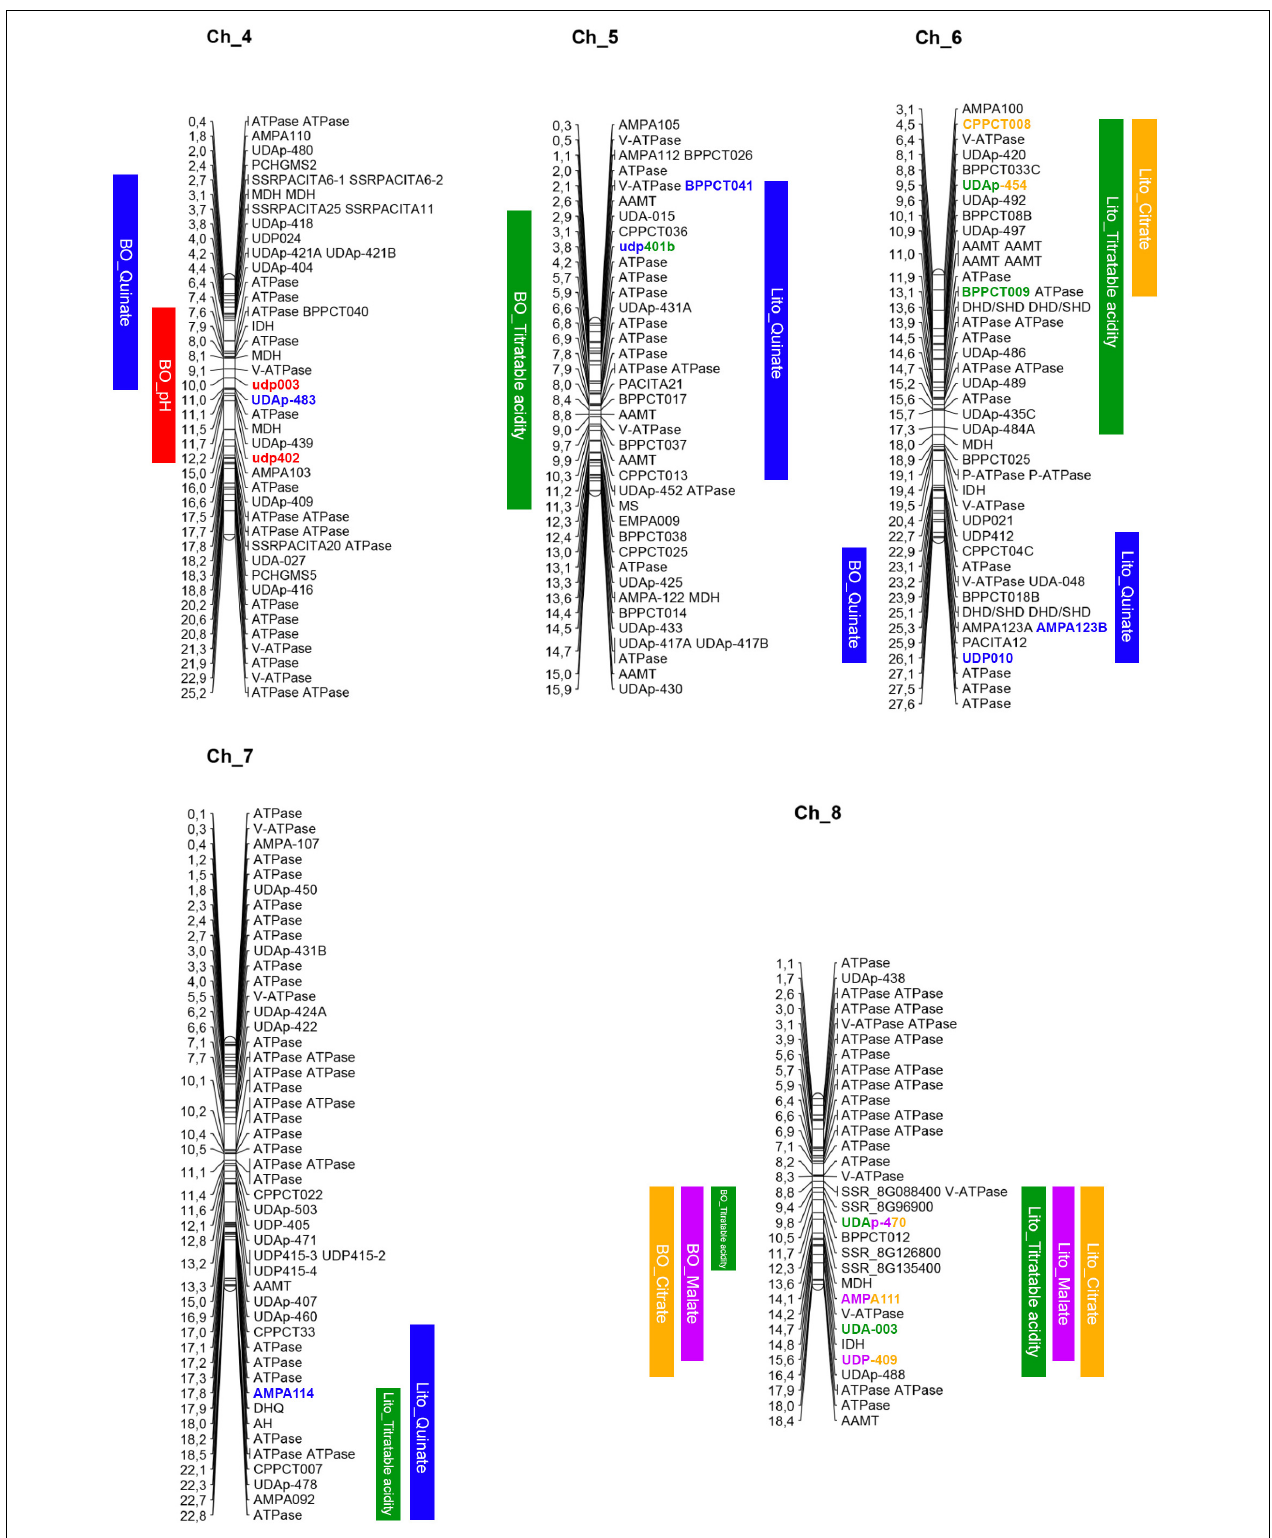
FIGURE 3 | Apricot physical maps including the positions of the QTLs regions (in colored bars for both parents, ‘Lito’ on the right and ‘BO81604311’ on the left) and of the acidity-related candidate genes. IDH, isocitrate dehydrogenase; MDH, malate dehydrogenase; AAMT, aluminum-activated malate transporter; MS, malate synthase; DHD/SDH, bifunctional 3-dehydroquinate dehydratase/shikimate dehydrogenase; DHQ, dehydroquinate synthase.